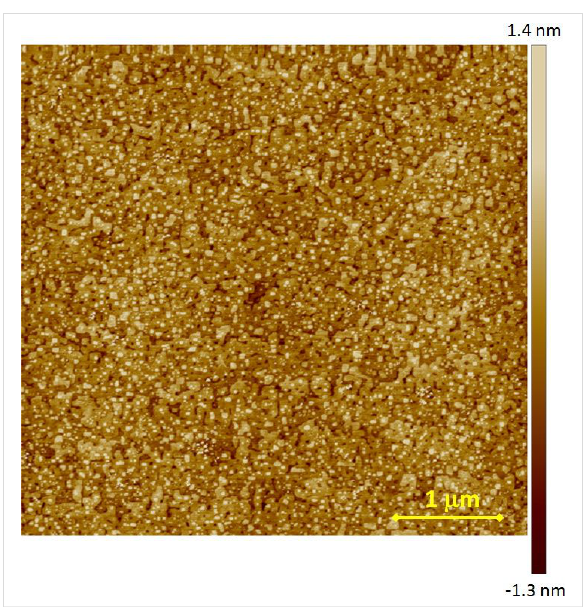
Figure 4: AFM image of 25 nm thick La 2 CuO 4 film on LSAO